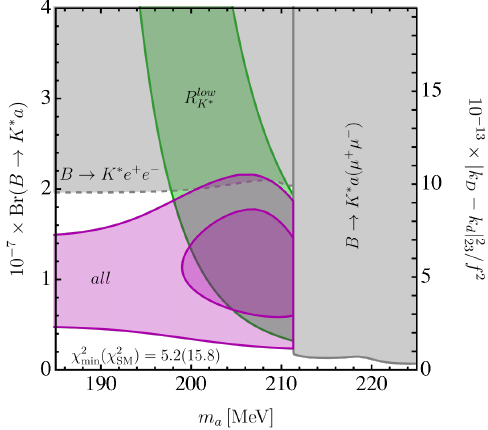
Figure 29 . The parameter space where a light ALP resonance with flavor universal couplings c ee /f = c µµ /f = c ττ /f can explain the low- q 2 bin of the R K ∗ measurement at 68 . 27% CL (green). The bounds from B → K ∗ e + e − [142] (dashed) and from searches for peaks in the di-muon mass spectrum [144] (solid) are shown at 95% CL in grey. The preferred regions of ∆ χ 2 = χ 2 − χ 2 corresponding to 68 . 27% CL and 95 . 45% CL are shown in light and dark purple,